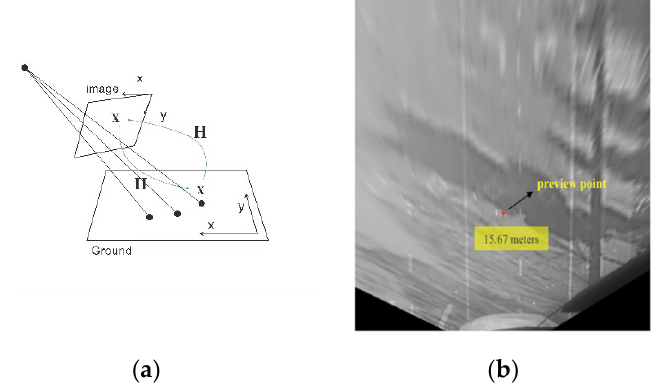
Figure 14. ( a ) Schematic diagram of projection transformation. ( b ) Preview point after projection.